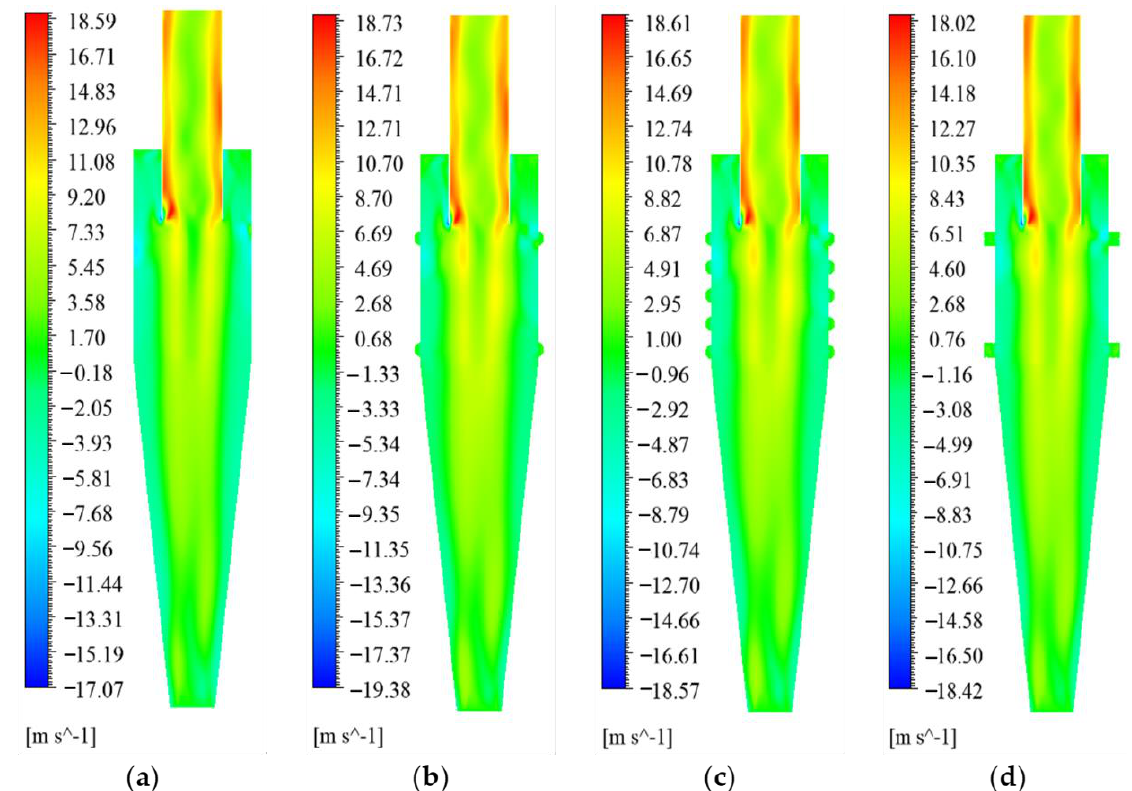
Figure 5. Contour plots of axial velocity of cyclone models; ( a ) Stairmand cyclone separator, ( b ) Model B cyclone separator, ( c ) Model C cyclone separator, ( d ) Model D cyclone separator.